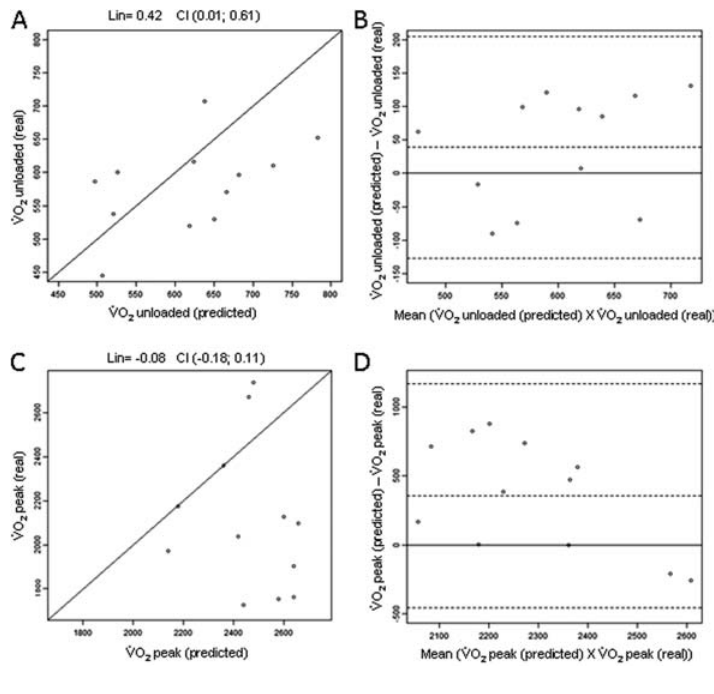
Figure 4. Lin ’ s concordance coef fi cients and Bland and Altman analysis in the coronary artery disease group. Lin ’ s concordance coef fi cient : O 2unloaded ð predicted Þ vs V for V Bland and Altman analysis of V : O 2unloaded ð real Þ ð B Þ in the unloaded condition. Lin ’ s V concordance coef fi cient for (V : O 2unloaded ð real Þ Þ ð C Þ and Bland and Altman analysis V : O of V